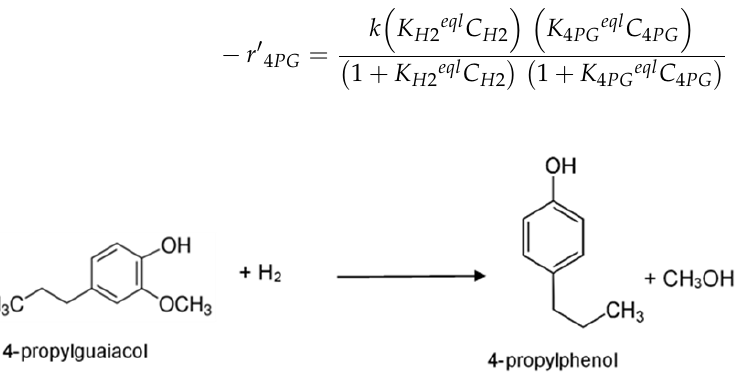
Figure 9. Reaction pathway considered for the catalytic HDO of 4-Propylguaiacol to 4-propylphenol.